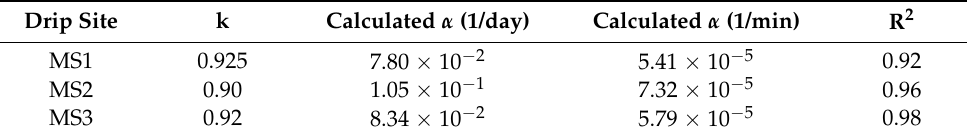
Table 2. Correlation method results for baseflow of MS1, MS2, and MS3, including recession coeffi- cient (k) and R 2 for the best fit on the envelope. Conversion from k to α (1/day) was done using Equation (4).